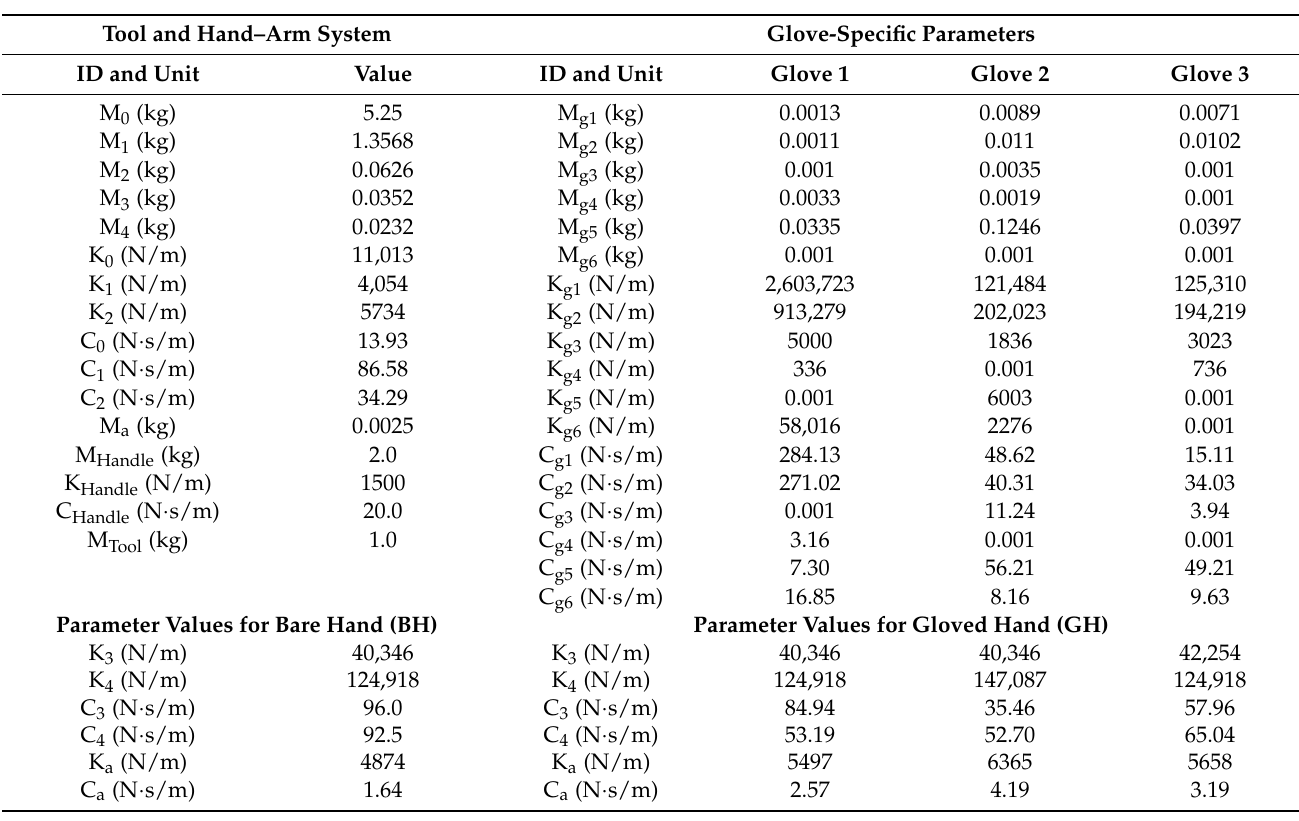
Table 1. The model parameter values for four hand treatments (bare hand and wearing each of the three different gloves: Glove 1, Glove 2, and Glove 3) considered in this study, most of which were determined from a previous study [15]. Tool and Hand–Arm System Glove-Specific Parameters